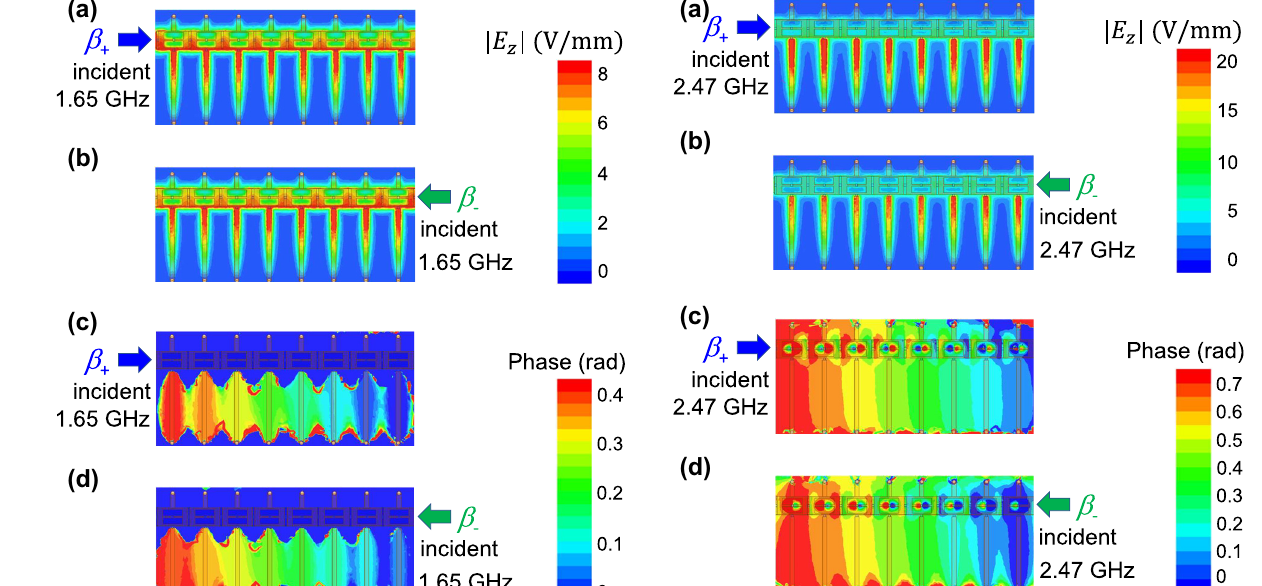
To confirm the validity of the simulated dispersion curves in Figure 5a, simulated magnitude and phase pro- fi les of the electric fi eld component E along the trans- z mission line are observed around at the Dirac points in the lower and higher CRLH passbands and plotted in Figures 7 and 8, respectively. Figures 7 and 8 represent the fi eld pro fi les measured at 1.65 and 2.47 GHz. The phase distri-